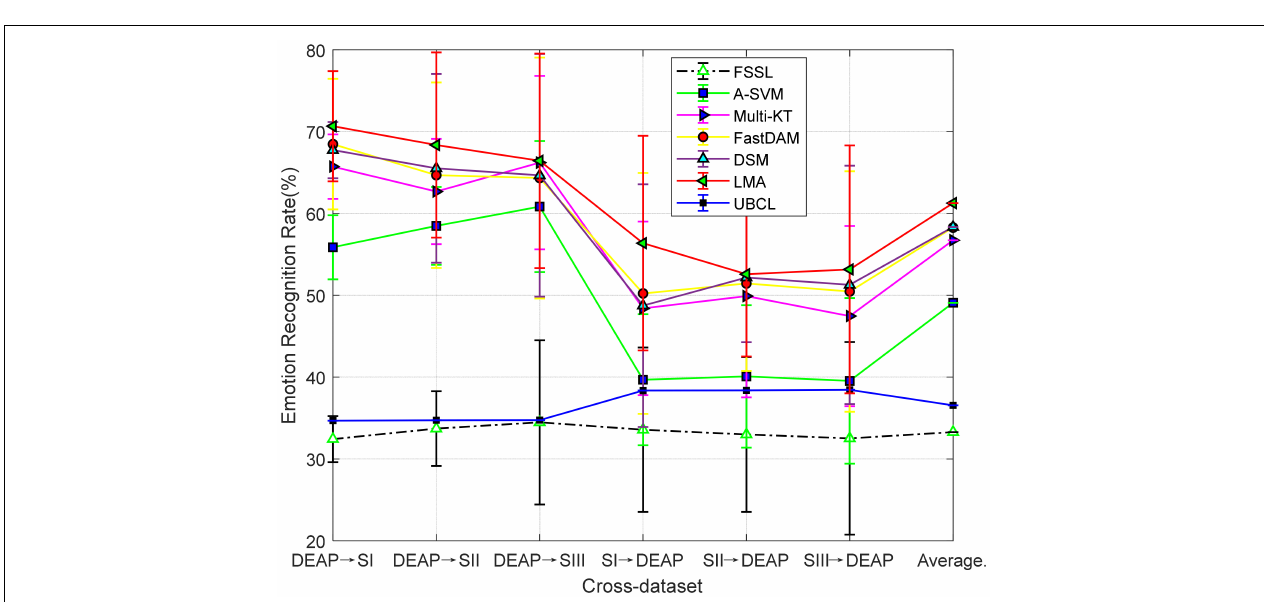
FIGURE 4 | Domain adaptation emotion recognition on cross-dataset (SI: Session I, SII: Session II, SIII: Session III).